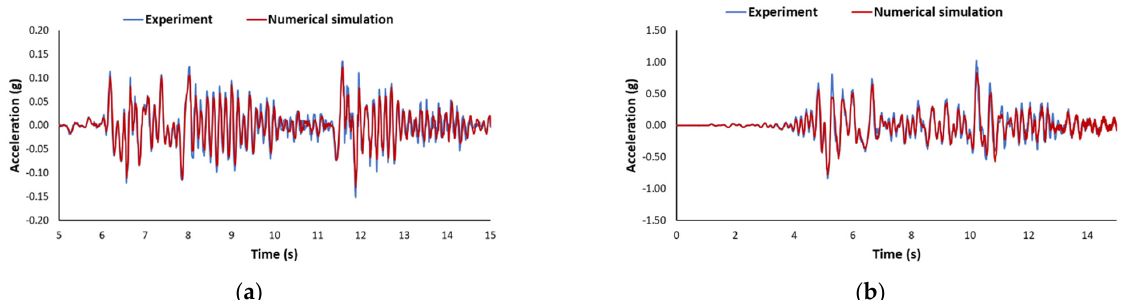
Figure 8. Displacement − force hysteresis for the numerical model and the experiment performed by Petry and Beyer [43] ( a ) PUP1, ( b ) PUP2.